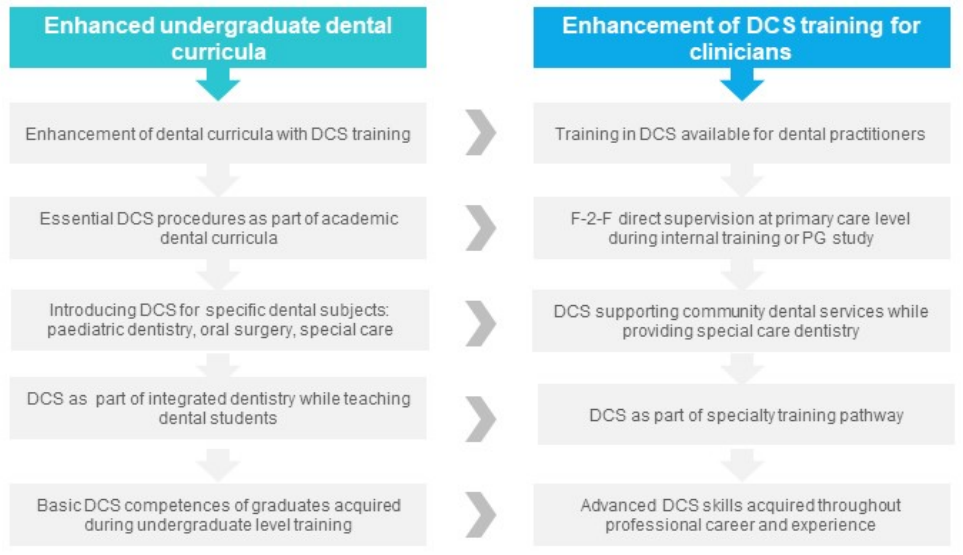
Figure 3. Proposed optimized approach for enhanced dental conscious sedation teaching and training.